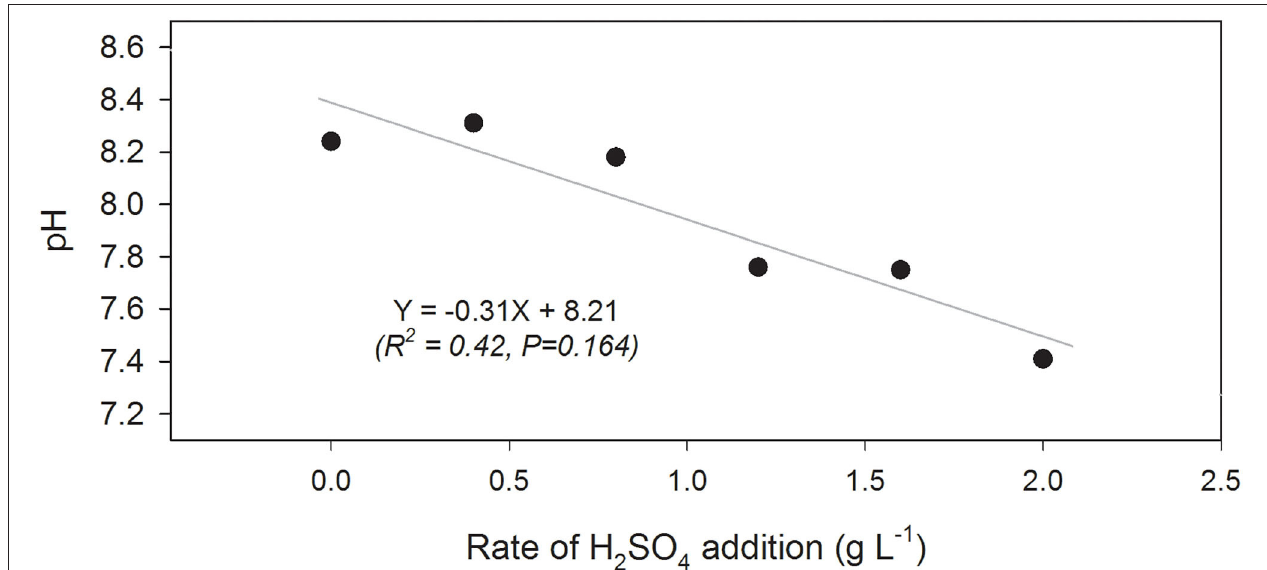
FIGURE 2 | Linear regression of manure pH and rate of sulfuric acid (H 2 SO 4 ) addition (g L − 1 ) from beginning of trial (June 10).